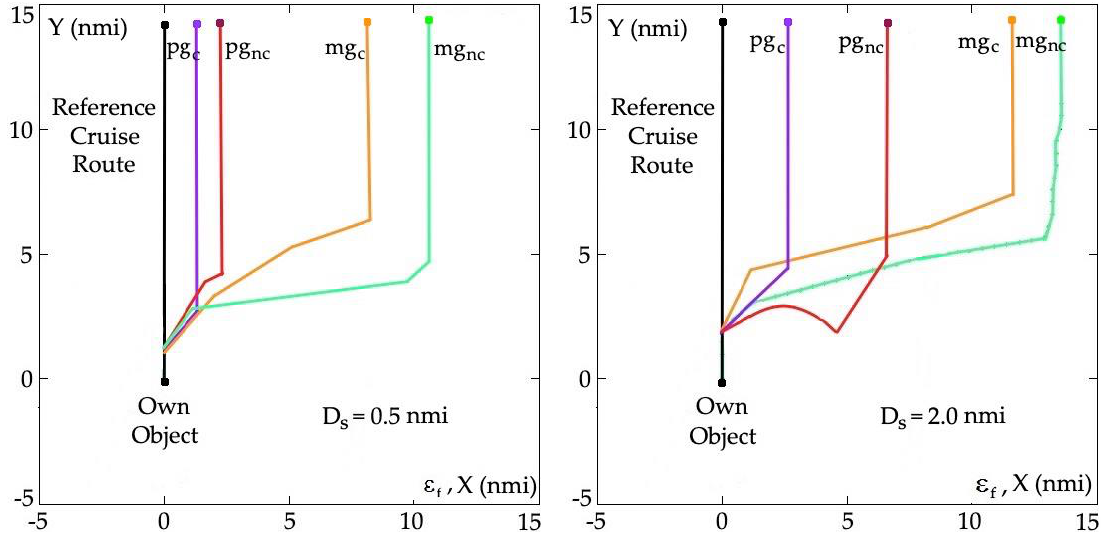
Figure 12. Safe trajectories of the own object during good visibility at sea at D s = 0.5 nmi (left)